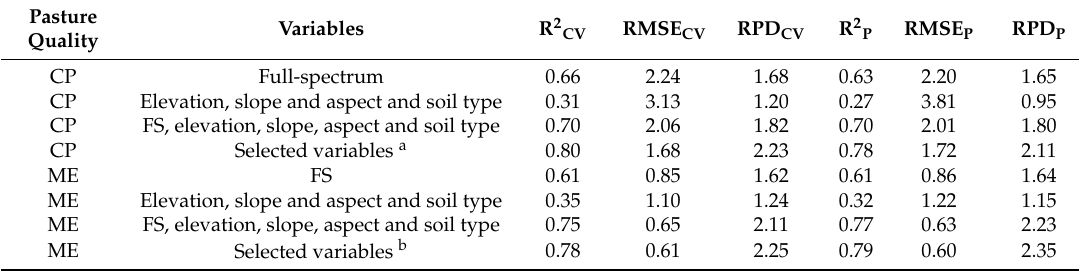
Regression model results for crude protein (CP) and metabolizable energy (ME) using airborne hyperspectral imaging. Regression metrics are R 2 CV -cross-validated coefficient of determination, RMSE CV -cross-validated root mean square error, and RPD CV - cross-validated ratio to prediction deviation.